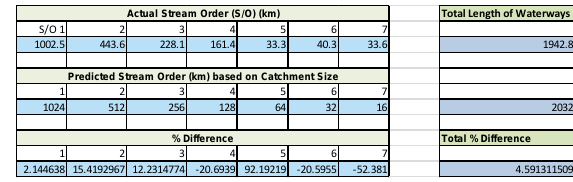
Table 3, SEQ - Stream Order, Land Use, Geology, Slope and Rainfall Information